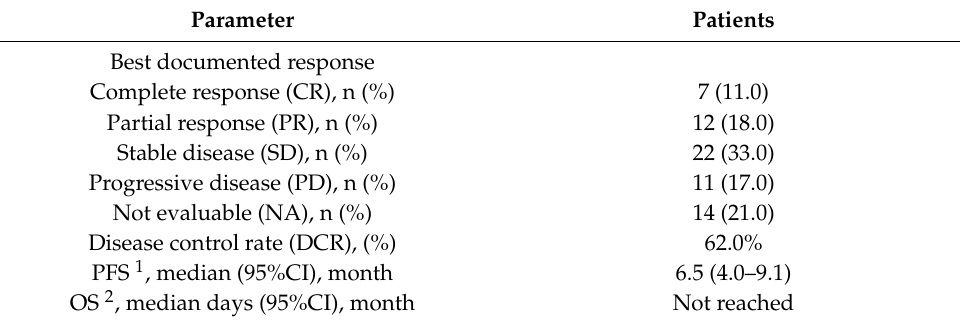
Table 2. Radiological response and survival data.